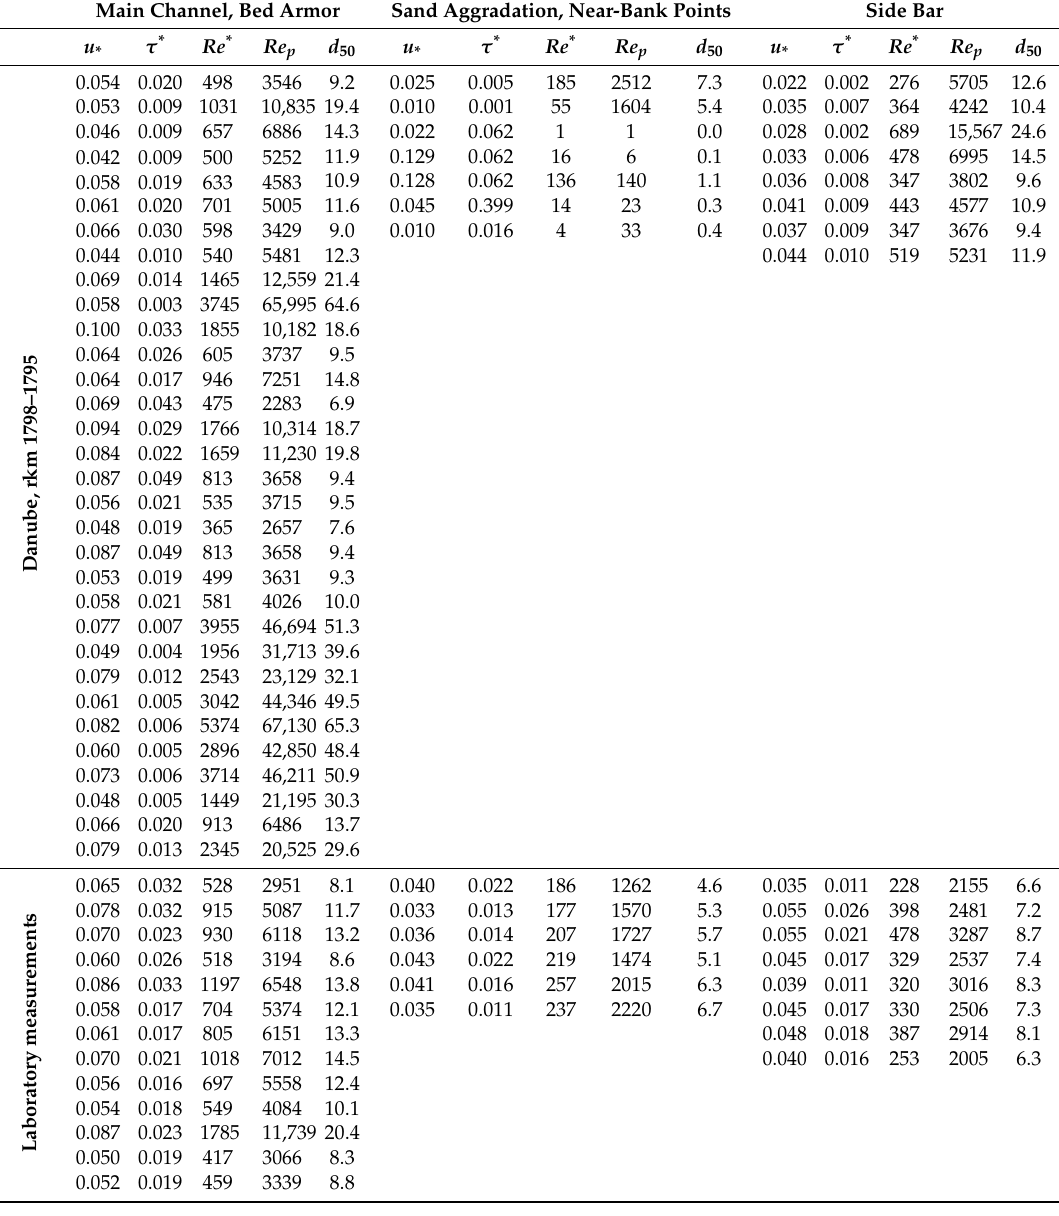
Table A1. Measured morphodynamic data of field [17,64] (at the introduced reach of the Danube River in Hungary) and laboratory [59] measurements and of the referenced laboratory experiments